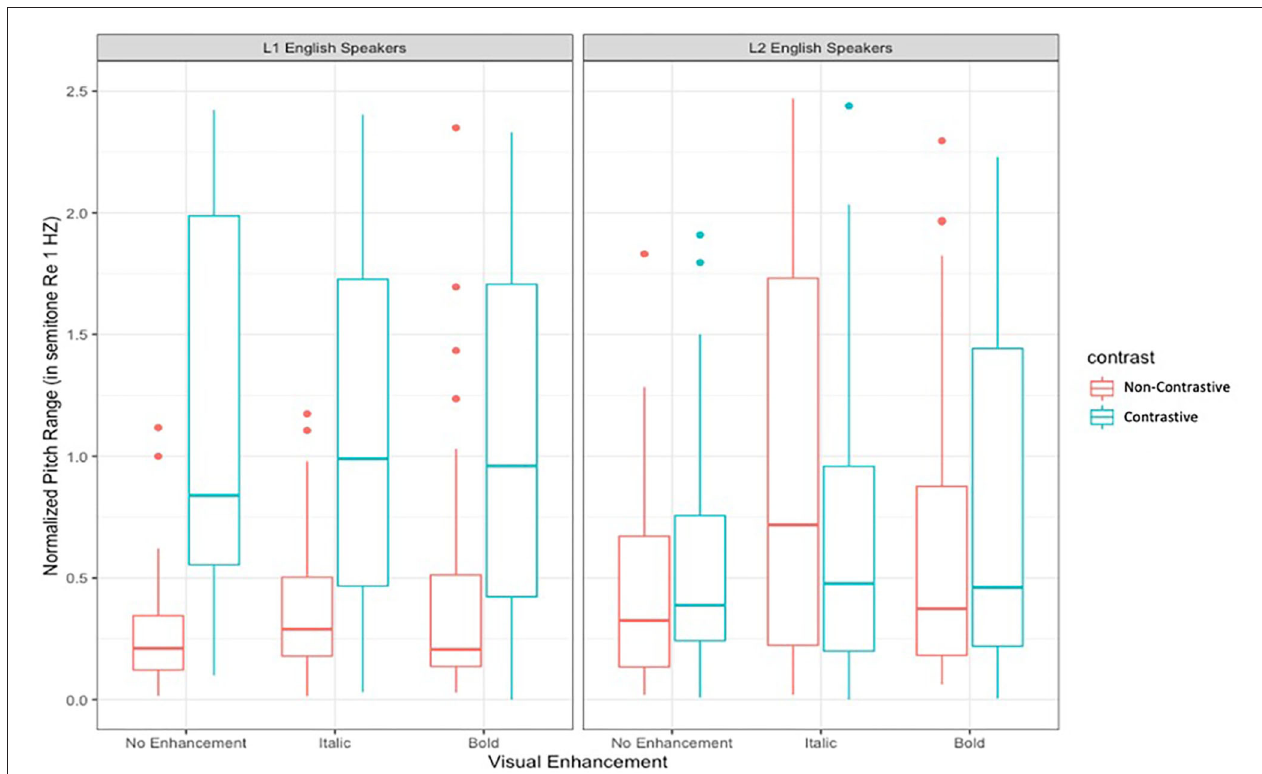
FIGURE 3 | L1 English and Mandarin-English L2 speakers’ speech production by visual